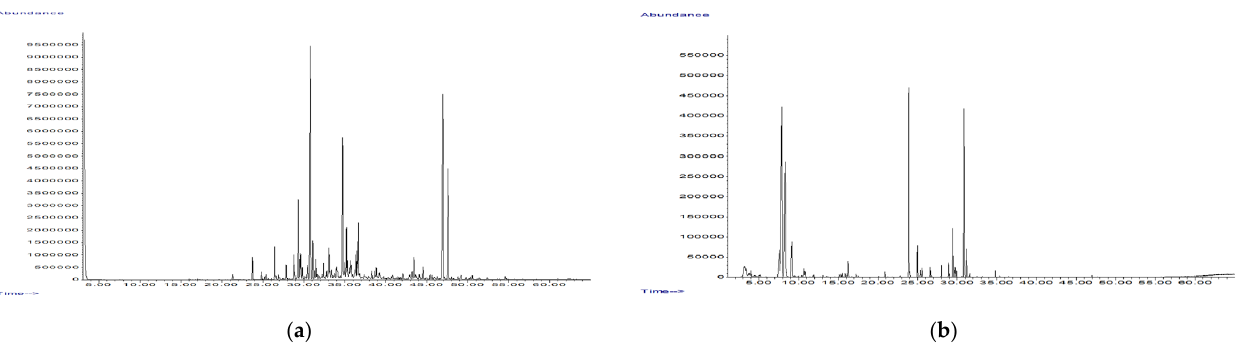
Figure 2. GC-MS chromatograms of essential oil isolated from sample P ( a ) and volatiles isolated by HSS technique from sample P ( b ).